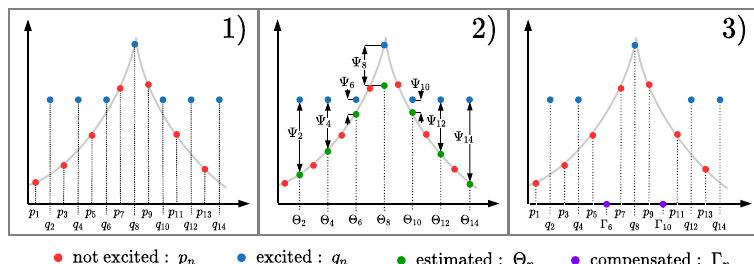
Figure 19. Procedure for determining the quality of the system response.